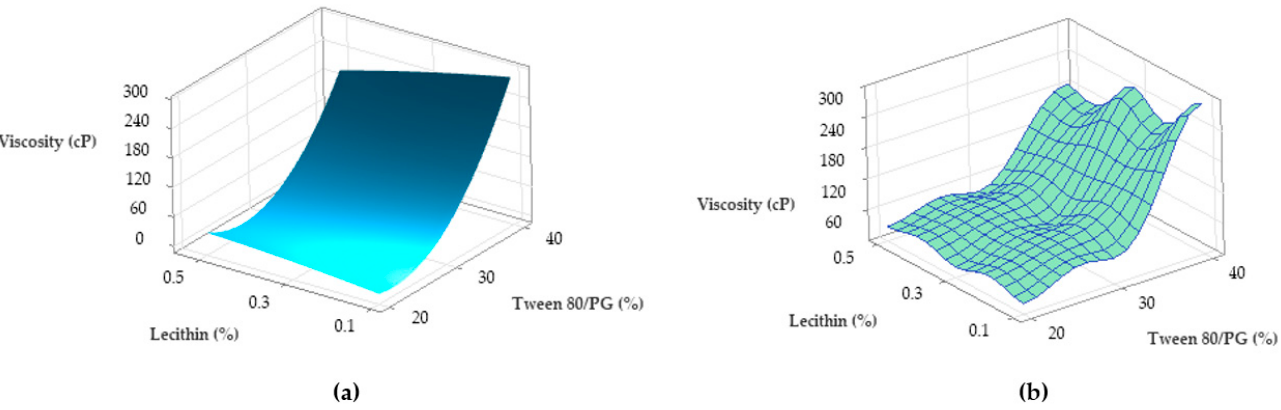
Figure 14. Main effects plot for viscosity response (Y 1 ), considering individual effect of each inde- pendent variable. As a final point, a predictive response on optimal viscosity was proposed. The tar- geted goals to successfully run the response optimizer consisted in maximizing viscosity and imposing constraints on X 3 variable, by setting a high level of 2% as desired. The ob- tained solution indicated a system with X 1 : 40%, X 2 : 0.1%, and X 3 : 2% as the best fit to obtain a high response. Predicted viscosity was 263.83 cP, and the composite desirability was 0.8953. The solution of predictive response is presented in Table 9. Table 9. Response optimization for viscosity by maximizing the response and keeping X 3 at maxi- mum level. Solution